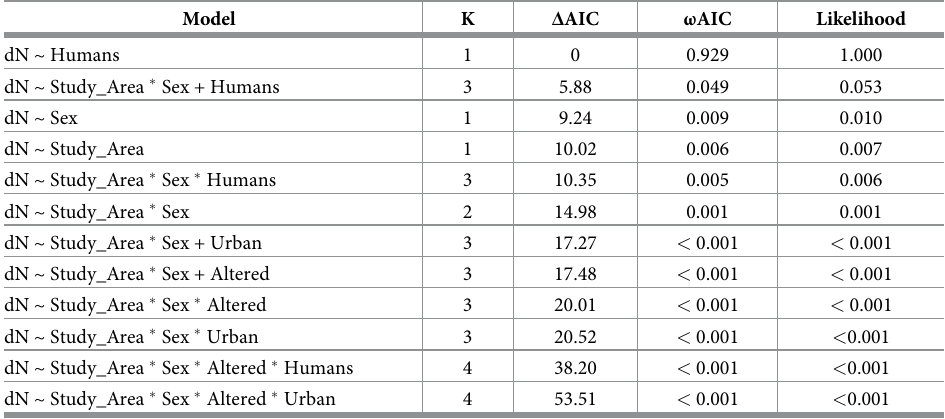
urban land cover, human density, or road density (Table 2). Nitrogen enrichment, generally regarded as representing the amount of protein in a consumer’s diet, decreased with increasing human density in the surrounding area (Table 4, Fig 5). Altered open space also had an effect on diet: scats from lines with more altered open space in their buffer zone had a reduced fre- quency of occurrence of anthropogenic items (Fig 2). The occurrence of anthropogenic items in scats was also affected by seasonality in suburban areas but not in urban areas (Fig 1). Table 4. AIC results for predicting nitrogen enrichment.